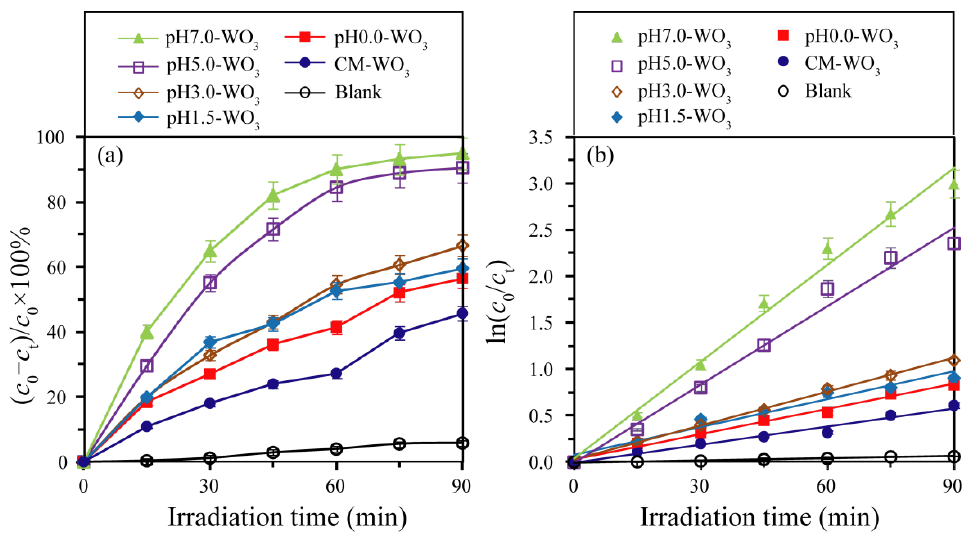
Figure 10. ( a ) Photocatalytic degradation curves of methylene blue solution and ( b ) corresponding kinetic fitting curves.